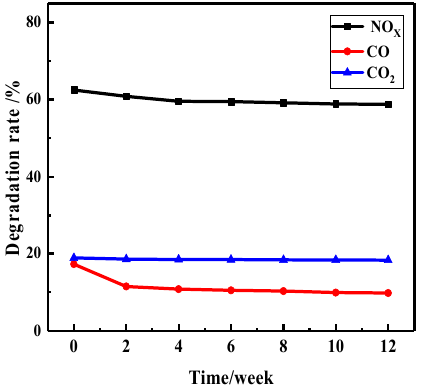
Figure 12. The durability for VE degradation performance of photocatalytic coating.